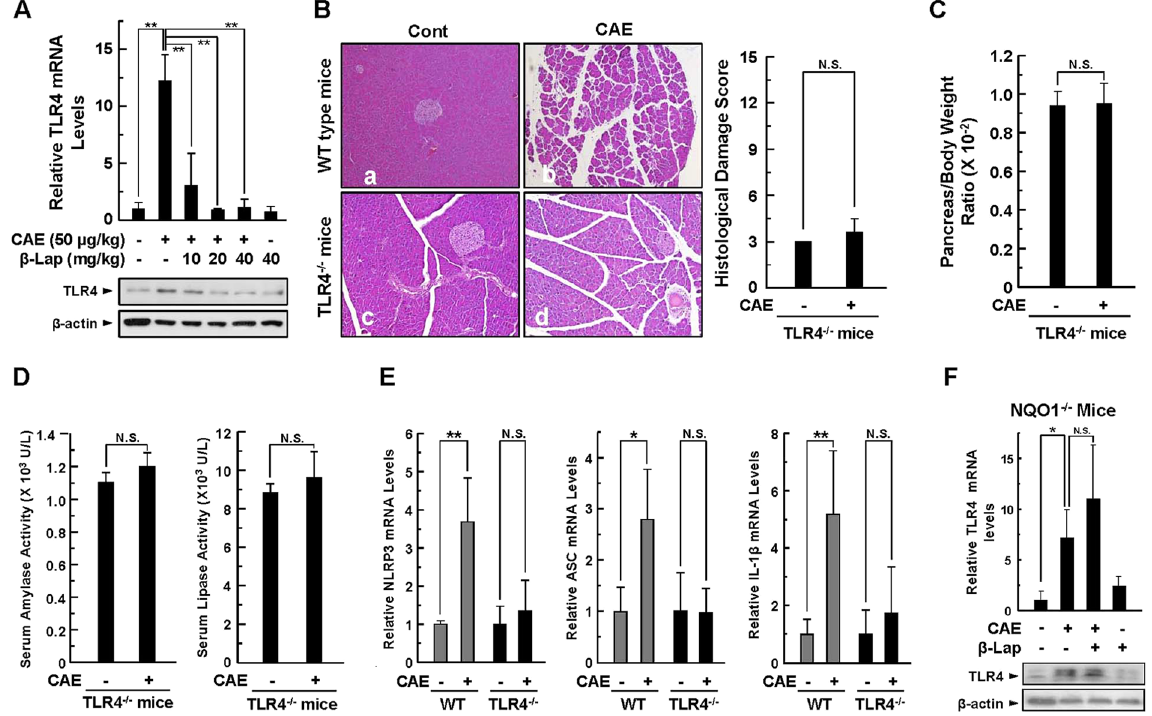
Figure 6. Effect of β -Lap on caerulein-induced AP in TLR4 − / − mice. TLR4 expression was determined in AP. ( A ) TLR4 mRNA and protein levels in pancreatic tissues were measured in WT mice by qRT-PCR and western blotting. ( B ) Pancreatic injury was estimated by H&E staining and the histologic damage score in WT mice and TLR4 − / − mice. Cont, saline (0.9% NaCl)-treated control group; CAE, 50 μ g/kg caerulein only group. ( C ) Pancreas/Body Weight Ratio. ( D ) Serum amylase and lipase activity. ( E ) Pancreatic mRNA levels of NLRP3, ASC, and IL-1 β were measured by qRT-PCR. ( F ) The TLR4 mRNA level and protein expression in NQO1 − / − mice were analysed by qRT-PCR and by western blotting. Each value represents the mean ± SD ( n = 5). * P < 0.05, ** P <